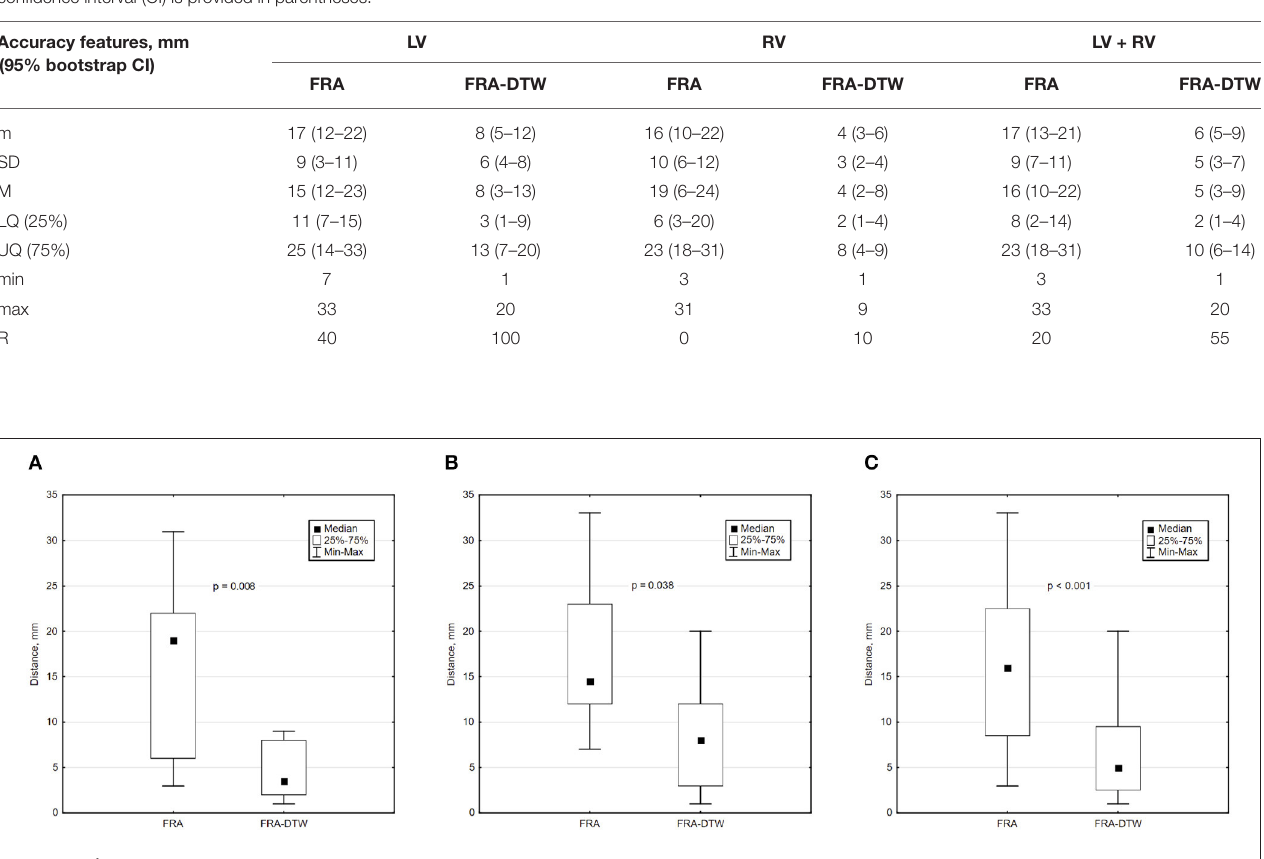
FIGURE 4 | Box and whisker plots of LEs for FRA and FRA-DTW for the LV (A) , RV (B) , and all considered pacings (C) . The Wilcoxon signed-rank test was performed to compare localization accuracy provided by the two ECGI algorithms. A p < 0.05 was considered as statistically significant due to the relatively small sample size.